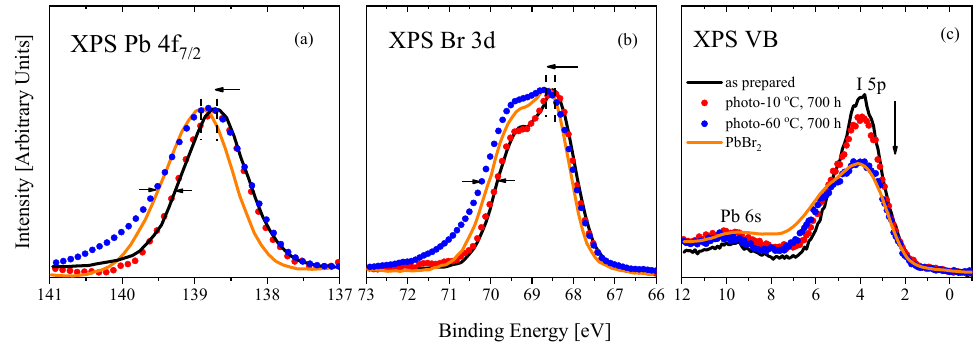
Figure 5. XPS Pb 4f ( a ), Br 3d ( b ), and VB ( c ) of MAPbBr 3 before and after light soaking at different temperatures.